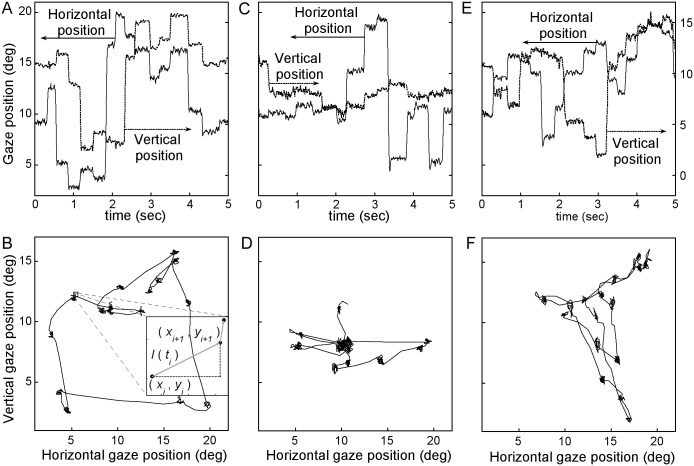
Sample gaze position and scan path data and plots of the scan paths of the same data below.Vertical and horizontal gaze position recorded for the five seconds of viewing for participant (A) Y1 and (C) FTD5 viewing a computer-generated fractal image and (E) FTD5 viewing a natural landscape. Along with plots of the scan path for (B) Y1, (D) FTD5 and (E) FTD5 of the accompanying data. The inset in (B) illustrates the magnitude of change in gaze position, l, between two gaze position data points in time.